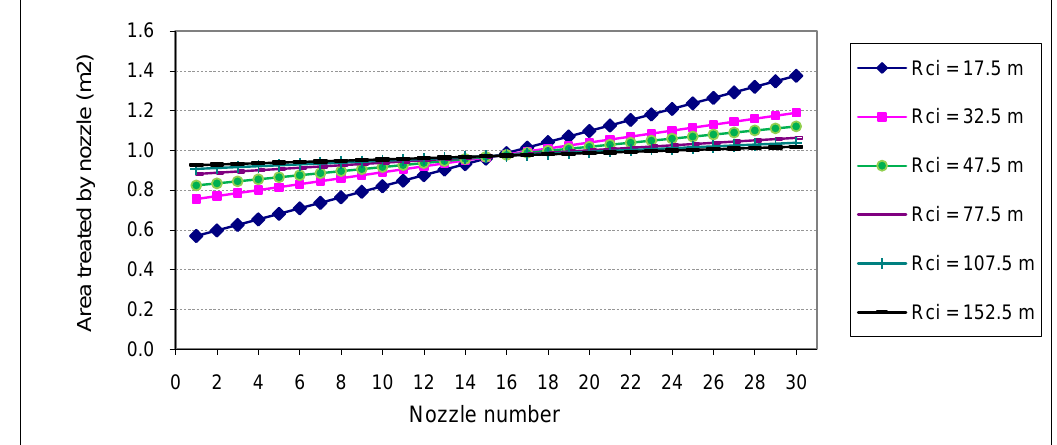
Figure 3. Area (m 2 ) treated by each nozzle of a 14.5-m-wide boom with 30 nozzles each separated by 50 cm as a function of the circular trajectory radius (Rci). Nozzle 1 = inner nozzle; Nozzle 30 = outer